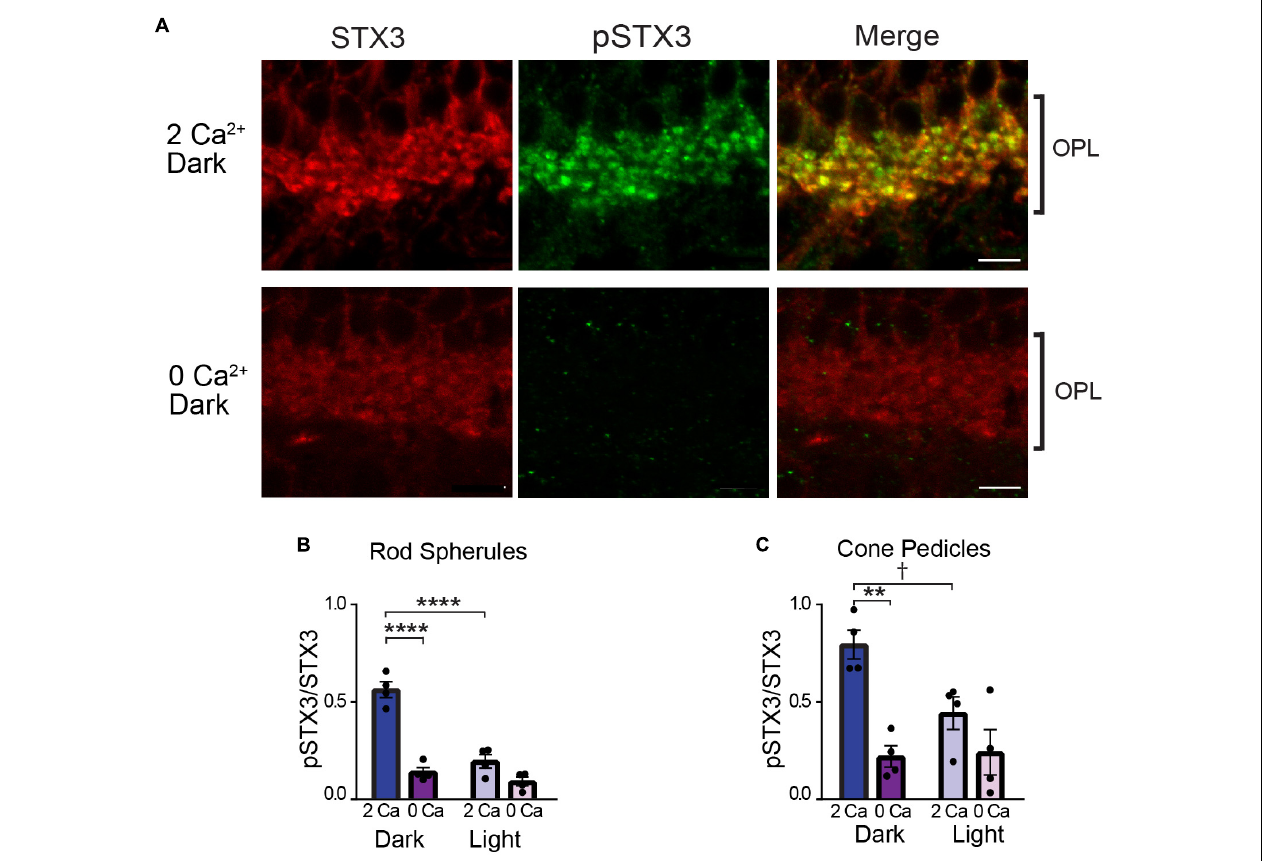
FIGURE 3 | External Ca 2 + is required for STX3 phosphorylation at T14 in both rod and cone photoreceptor terminals. (A) Representative confocal images through the OPL show that phosphorylation of STX3 at T14 in photoreceptors terminals in dark-adapted retinal eyecups (top panel) is abolished by the omission of Ca 2 + from the external bath solution (“O Ca,” bottom panel). Scale bar = 5 µ m. (B) In rod spherules, the pSTX3/STX3 ratio in dark-adapted retinal eyecups was greatly reduced in the absence of external Ca 2 + ( p < 0.0001) and indistinguishable from that of light-treated eyecups, with or without external Ca 2 + ; p = 0.6035 and 0.6928, respectively. (C) In cone pedicles, the high pSTX3/STX3 ratio in dark-adapted eyecups was reduced in the absence of external Ca 2 + to levels indistinguishable from that of light-treated eyecups, with or without external Ca 2 + ; p = 0.3016; p = 0.998, respectively. For (B,C) , n = 4,4 (mice). **indicates p < 0.01, ****Indicates p < 0.0001, and † indicates that p approaches